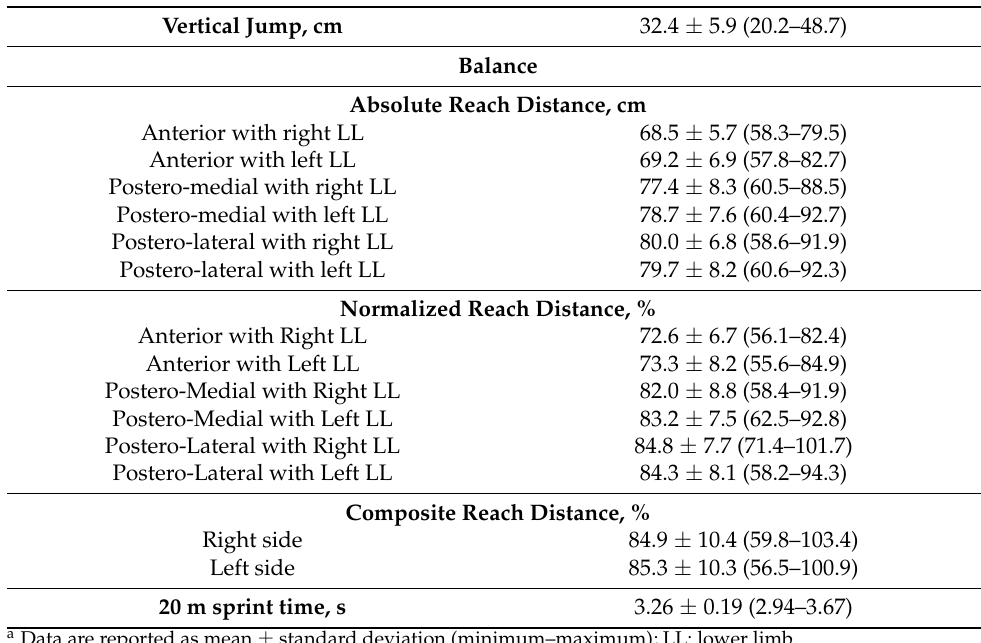
Table 3. Data on vertical jump height, balance and speed tests a .